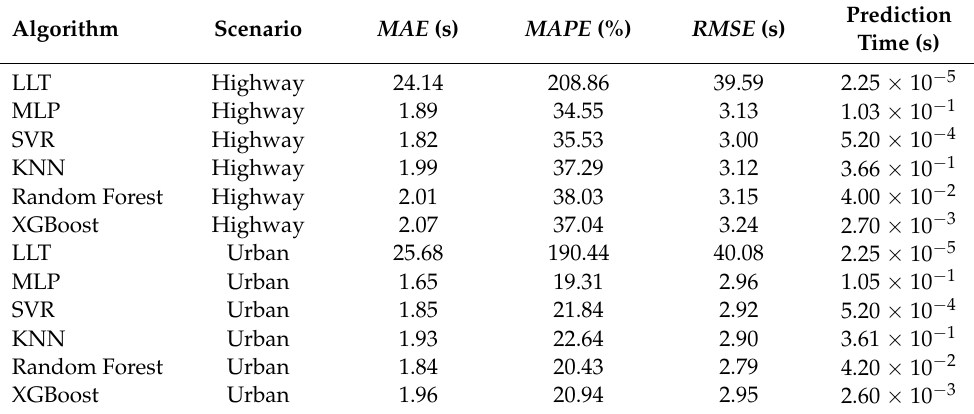
Table 4. Summary of the experimental